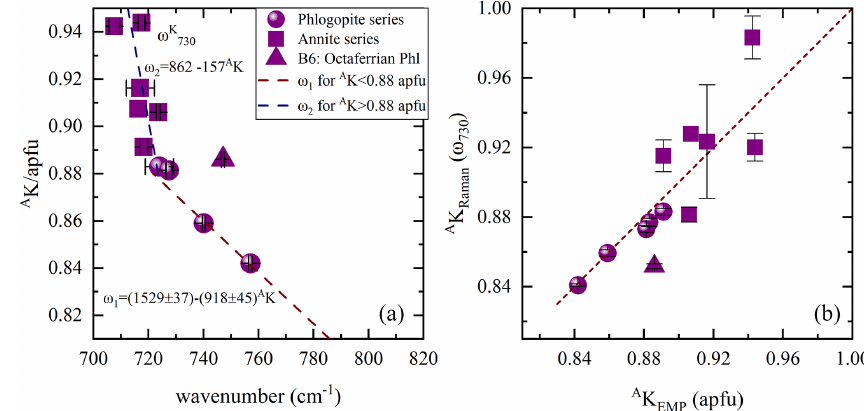
Figure 8. (a) Content of A-site coordinated K vs. ω 730 , where the Raman spectroscopic data are emerging from the y(zz)y scattering geometry, while in (b) A K Raman vs. A K EMP estimated from both ω 1 and ω 2 linear trends in (a) . Deviating point: triangle indicates sample B6, a phlogopite containing octahedrally coordinated Fe 3 + at concentrations of ∼